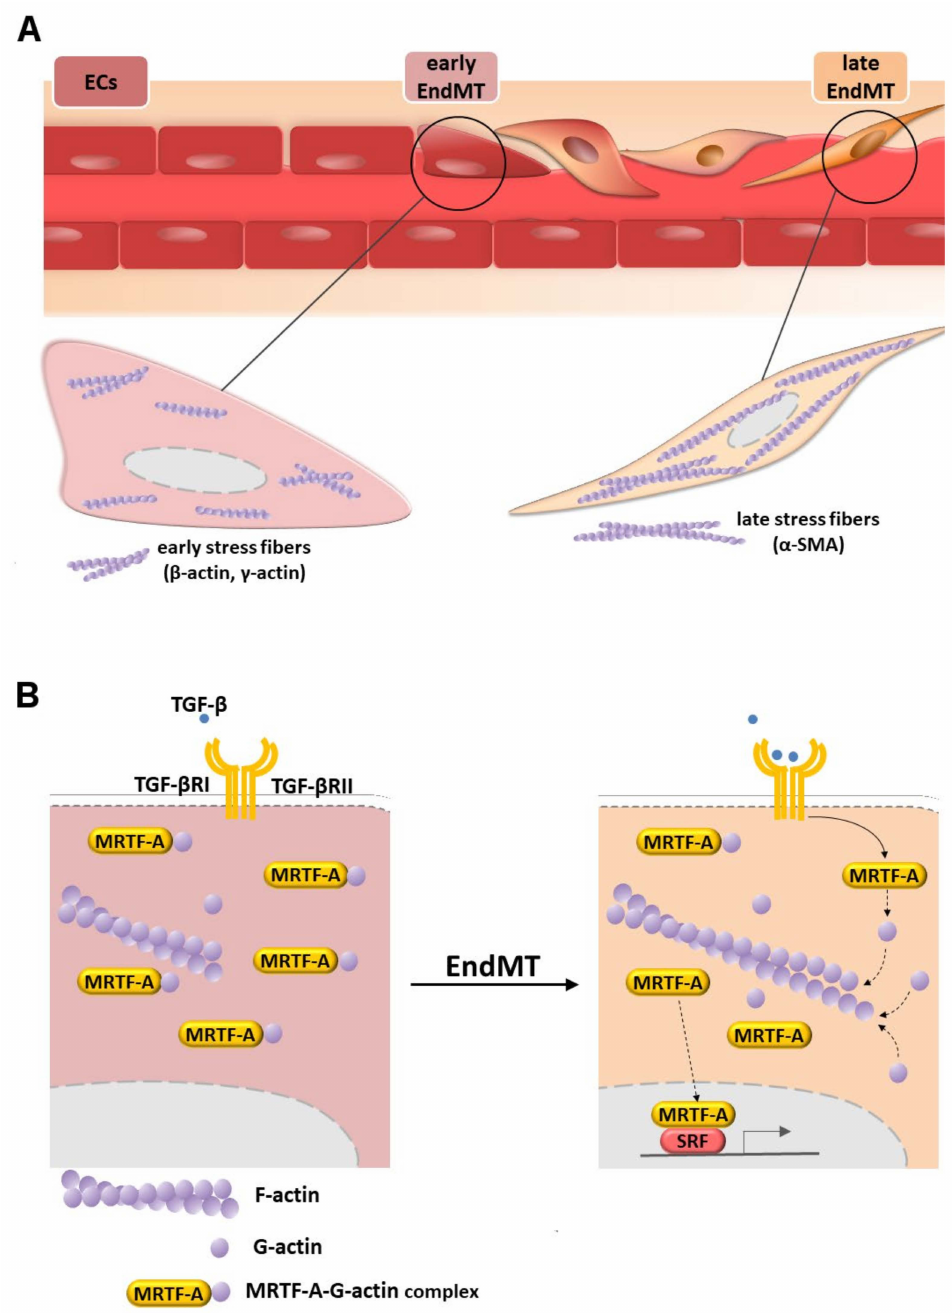
Figure 5. Microfilament remodeling during EndMT-induced stress fiber formation. ( A ) The early stages of EndMT are accompanied by early, non-maturated stress fibers composed of β -actin and γ -actin. In contrast, late stages of EndMT are characterized by late stress fibers created by α -SMA- enriched microfilaments. ( B ) Decomposition of actin microfilaments requires the recruiting of G-actin, which is released from the G-actin-MRTF-A complex. As a result, free MRTF-A translocates to the nucleus and induces the transcription of protein involved in the regulation of the cytoskeleton reorganization ( α -SMA, focal adhesion kinase (FAK), and integrin-liked kinase (ILK)) and cell contraction (caldesmon and